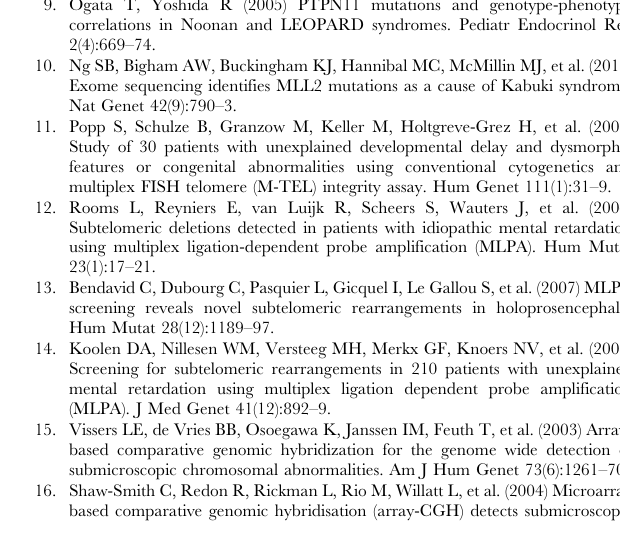
Table S1 List of heart malformations present in the cohort of 33 studied fetuses with isolated congenital heart defect. RHH: right heart hypoplasia; IVC: interventricular communication; LHH: left heart hypoplasia; VSD: ventricular septal defect; D-TGA: dextro- transposition of the great arteries; L-TGA: levo-transposition of